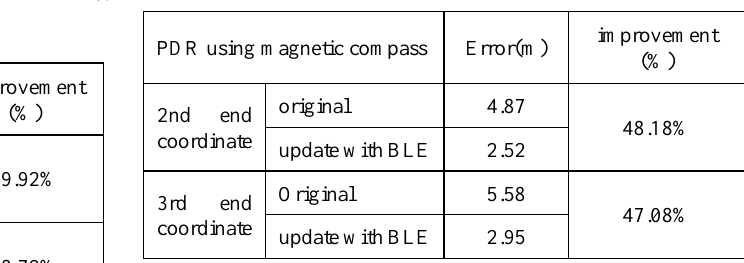
Table 5. The error of PDR using magnetic compass of